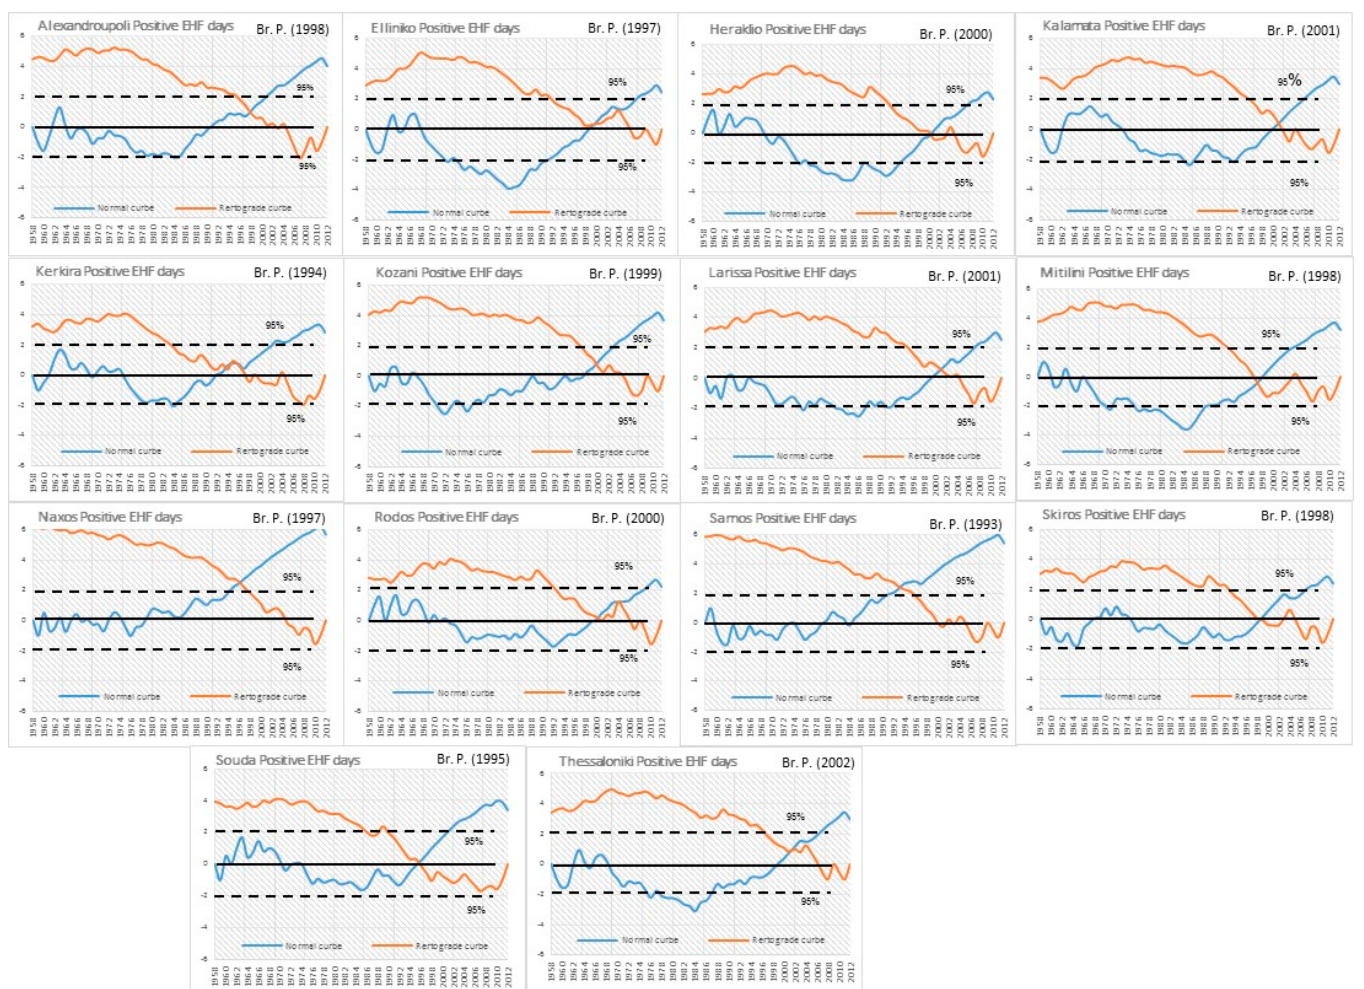
Figure 3. Mann–Kendall t test results on the statistically significant trends, at the 95% level, of the EHF positive days. In the upper right corner of each diagram, the year of the breakpoint (abrupt climatic change) is indicated in the brackets.